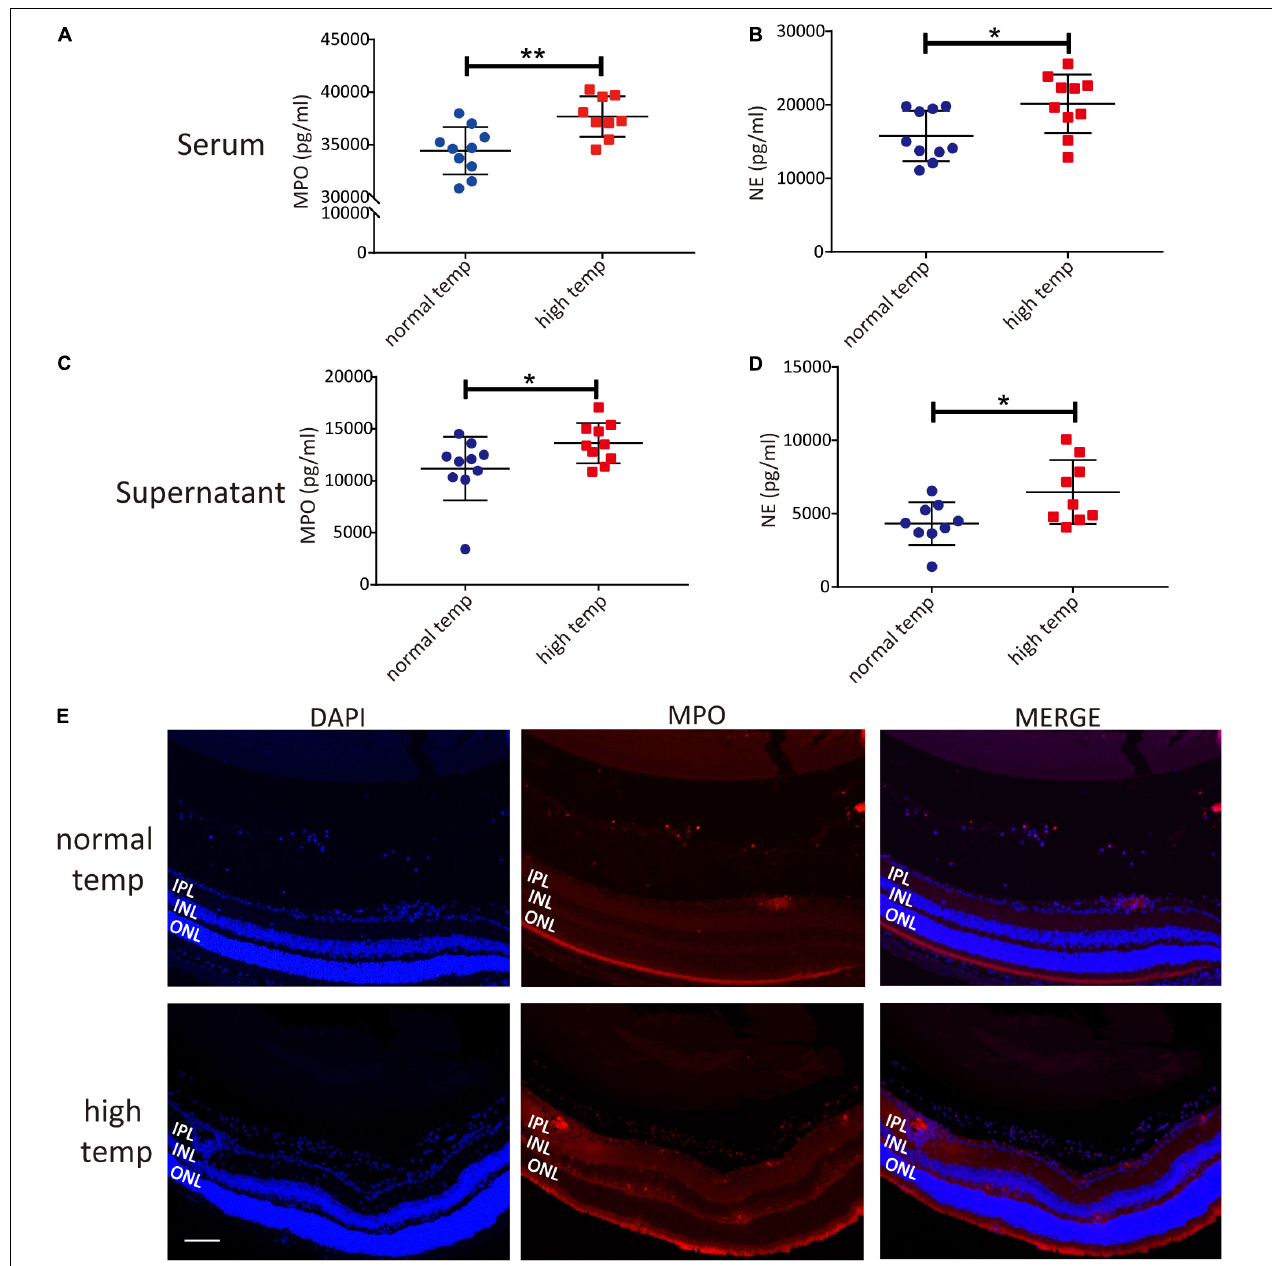
FIGURE 3 | A high temperature environment induces the generation of NETs in EAU mice. (A) Quantification of MPO in the serum of EAU mice ( n normal temp = 10; n high temp = 9; mean ± SD; ** p < 0.01, * p < 0.05; Differences were assessed by Unpaired t -test). (B) Quantification of NE in the serum of EAU mice ( n = 10/group; mean ± SD; ** p < 0.01, * p < 0.05; Differences were assessed by Unpaired t -test). (C) Quantification of MPO in neutrophil supernatants of EAU mice ( n = 10/group; mean ± SD; * p < 0.05; Differences were assessed by Unpaired t -test). (D) Quantification of NE in neutrophil supernatants of EAU mice ( n = 9/group; mean ± SD; * p < 0.05; Differences were assessed by Unpaired t -test). (E) Immunofluorescence analysis of MPO to label the location of NETs in the retinas of EAU mice.